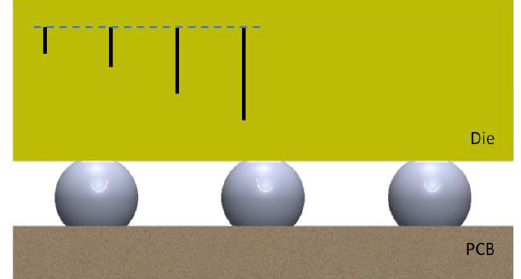
Figure 13. Schematic showing different crack lengths.